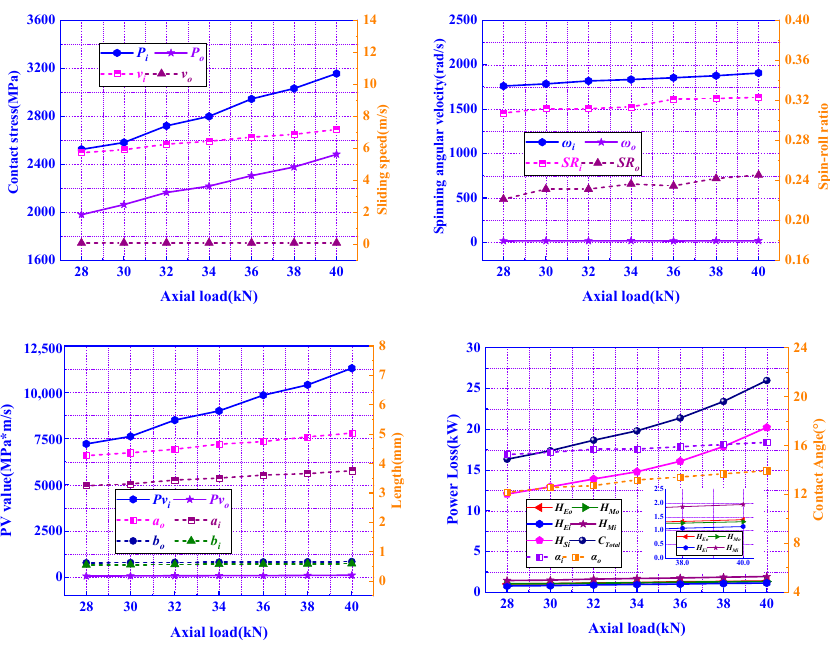
Figure 18. Influence of axial load F a on power loss.